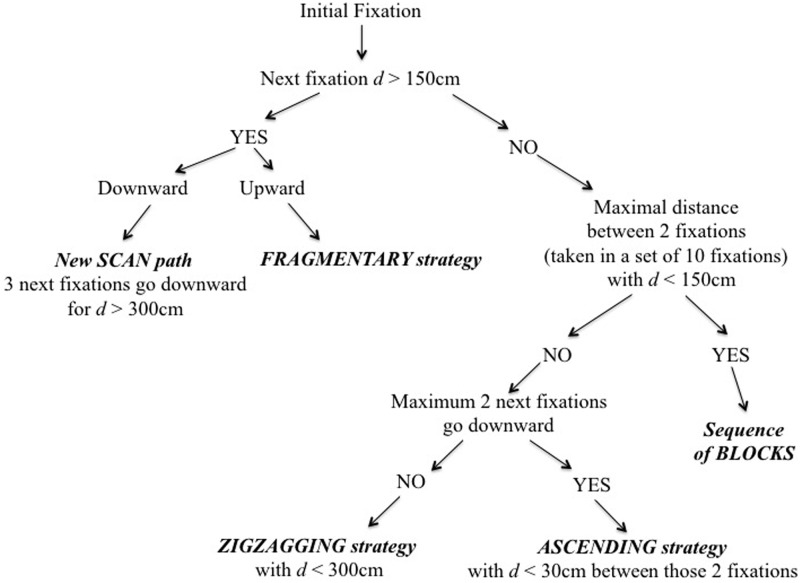
Decision tree to define the visual strategies during the route preview.